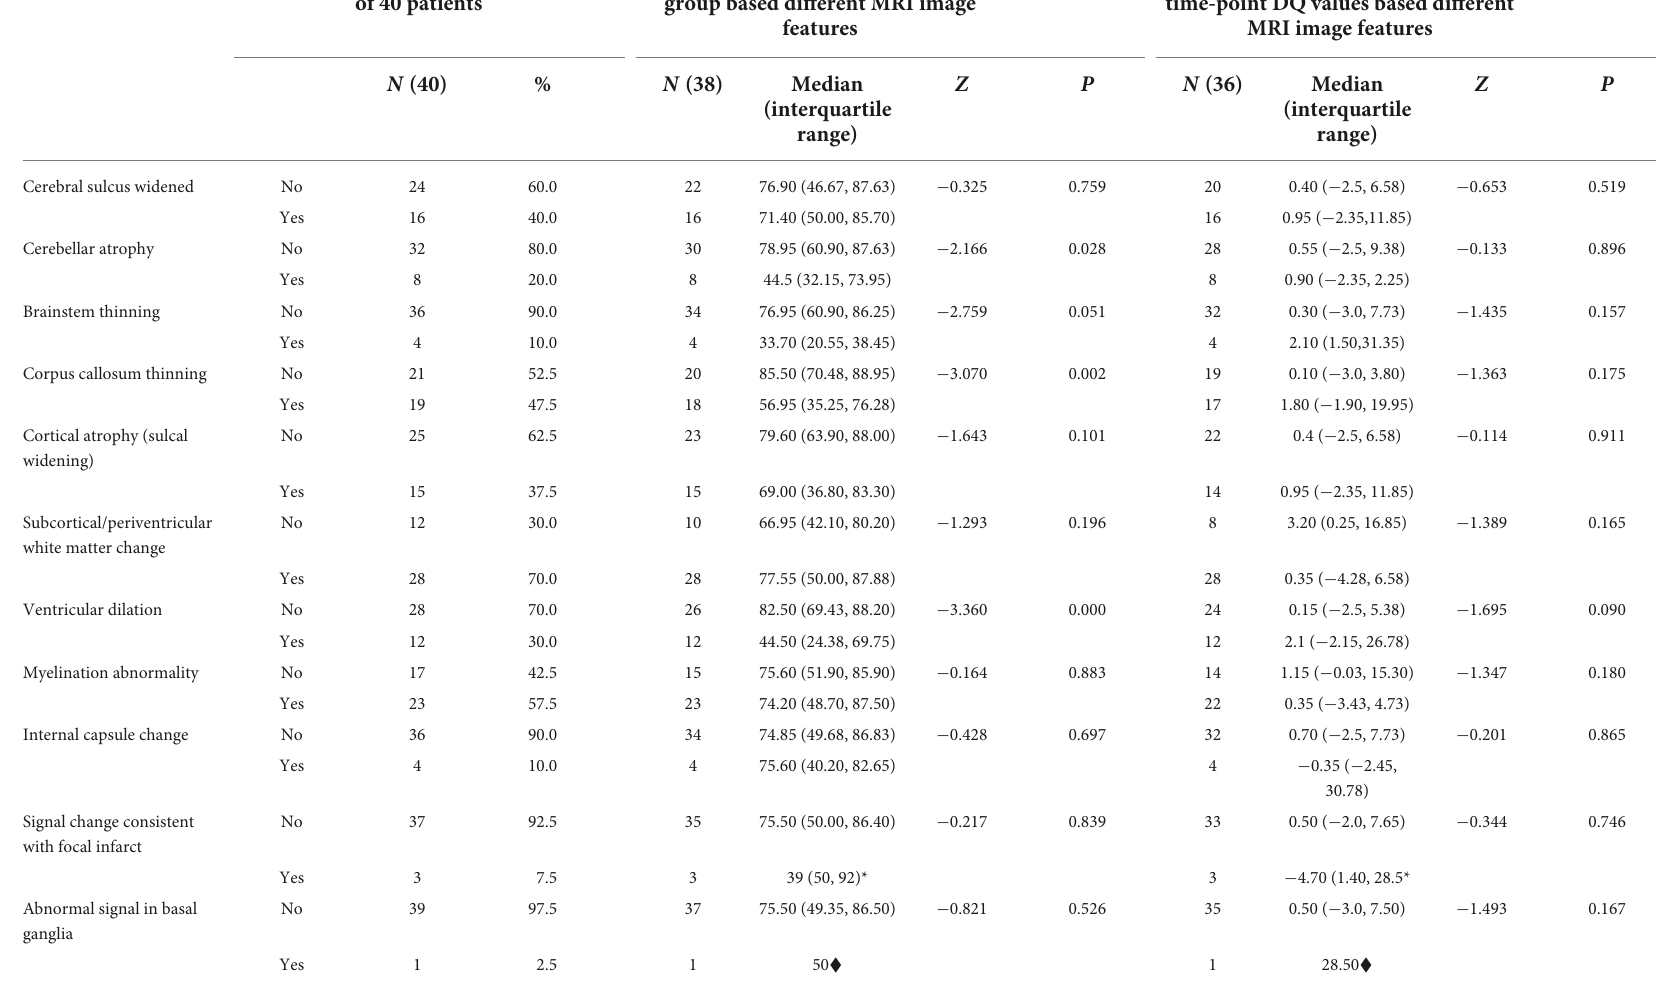
TABLE 1 Cerebral MRI characteristics in patients with cblC defects and comparison of DQ among different